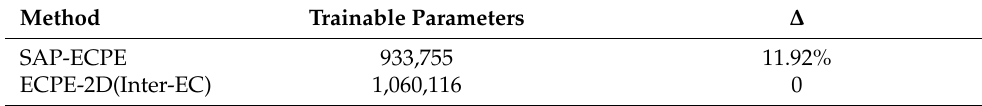
Table 3. Comparison of trainable parameters for SAP-ECPE and